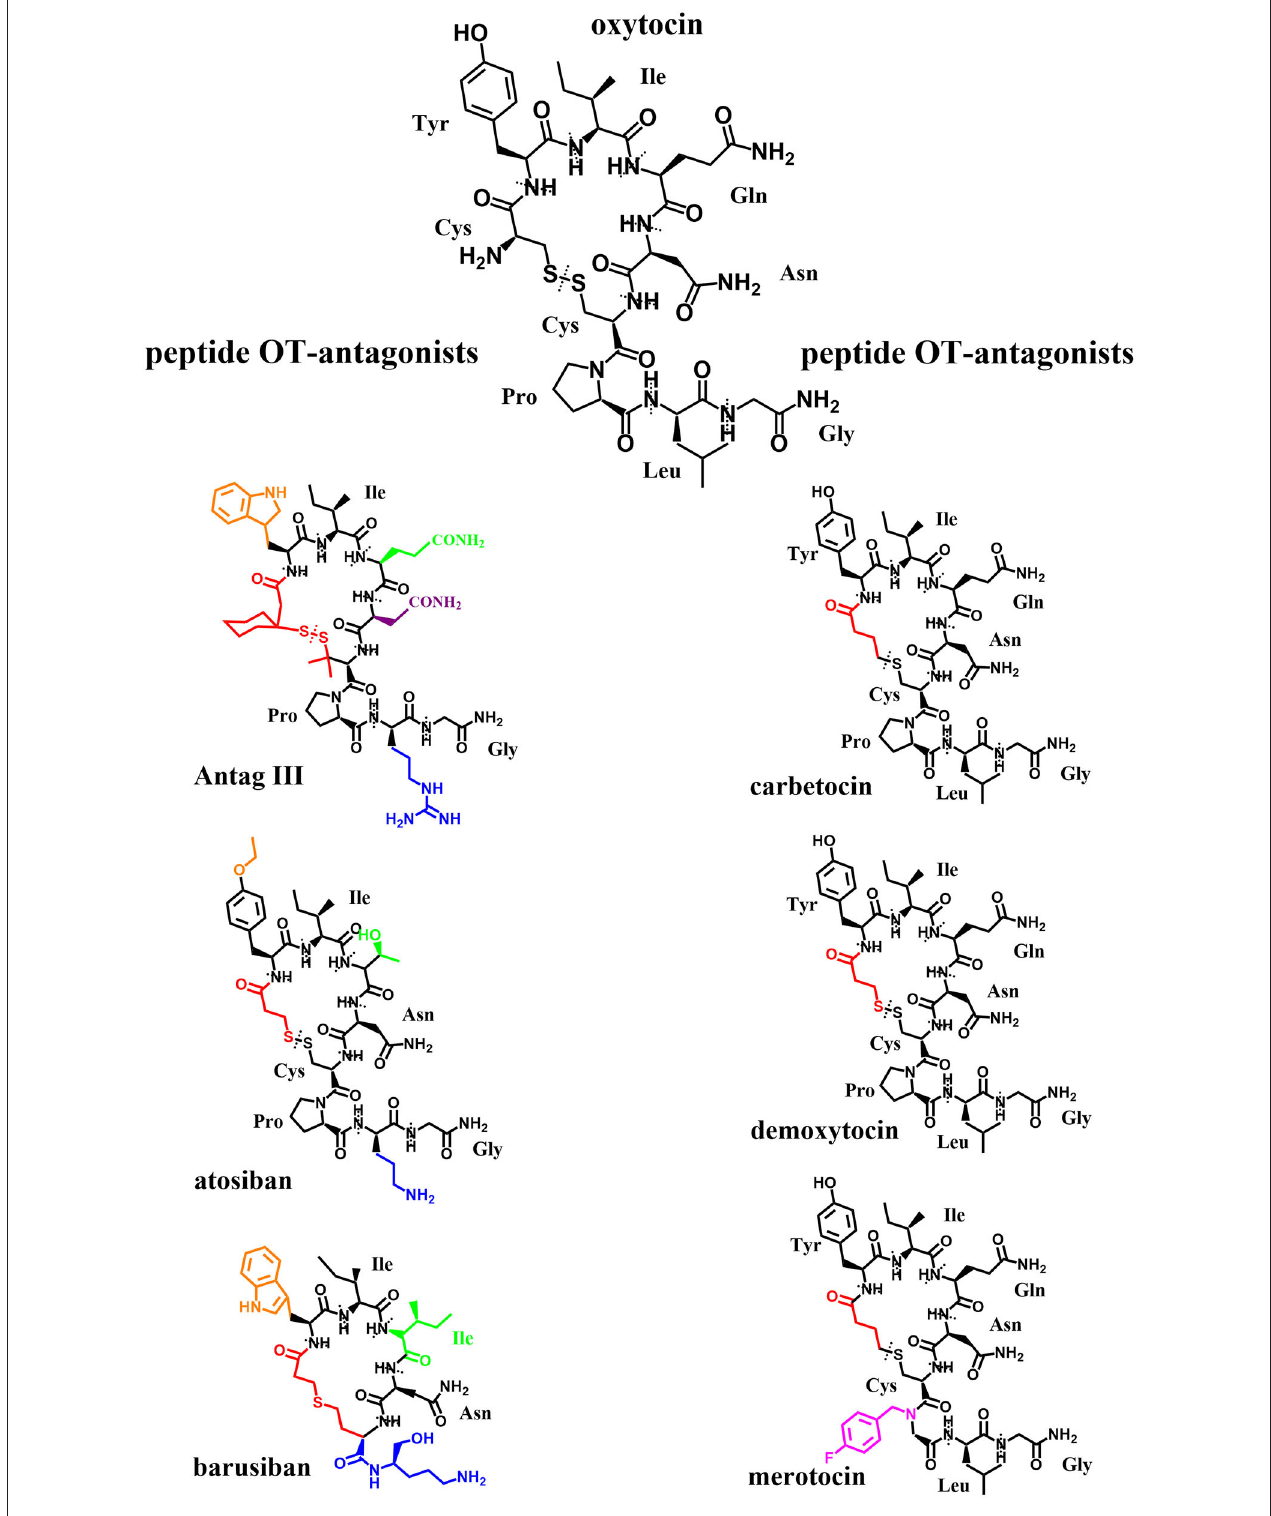
FIGURE 7 | Original: Chemical structures of OT and six peptide OT-agonists and -antagonists. Alterations in respect to OT have been highlighted in different colors. The different amino acids are labeled and separated by dotted lines.